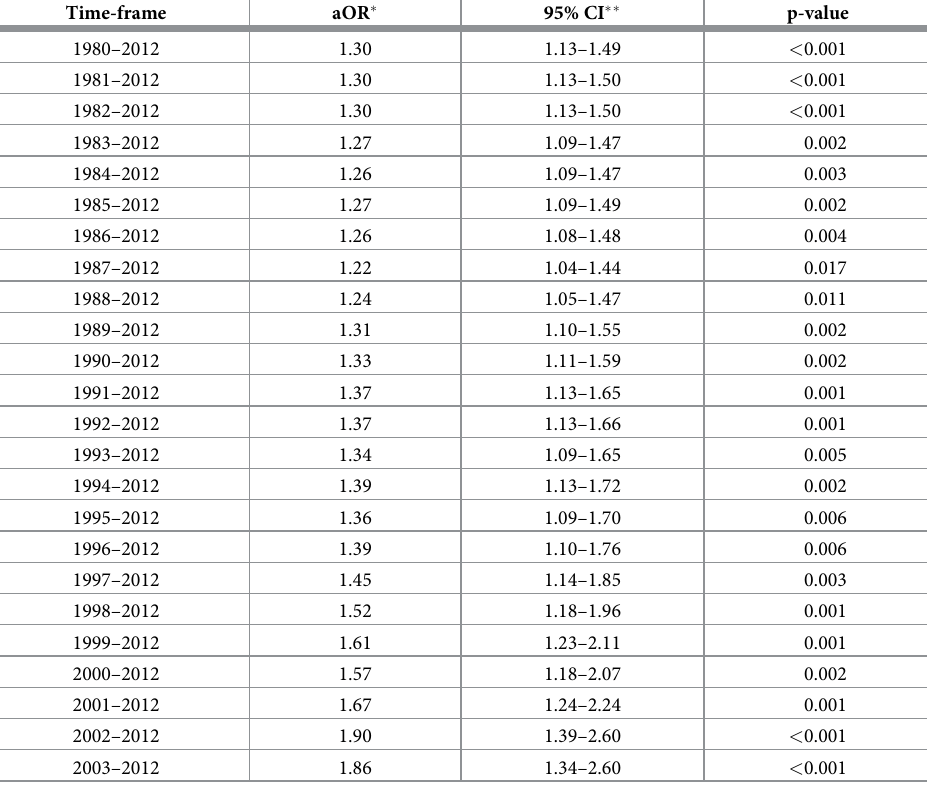
Table 2. The odds ratios of low household income among tuberculosis and non-tuberculosis group by periods. Time-frame aOR � 95% CI ��